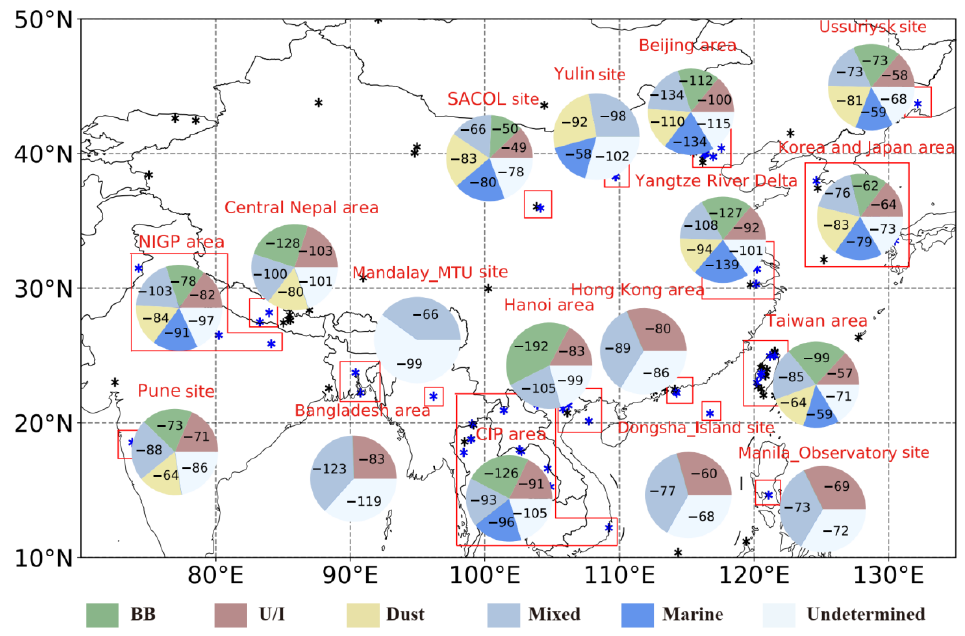
Figure 10. The same as Figure 9 but for the ARF BOA .